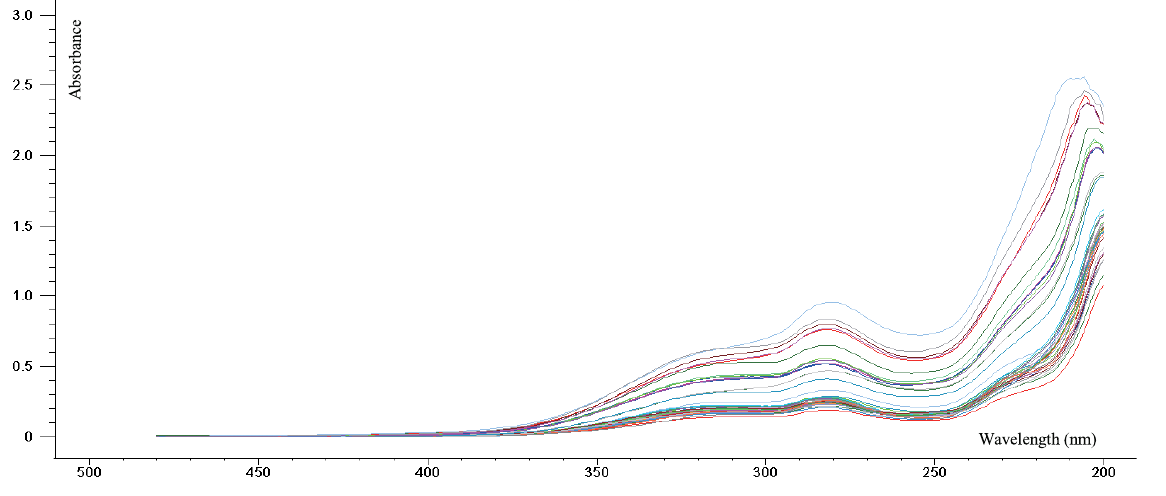
Fig. 1. Raw UV spectrum of 41 injection